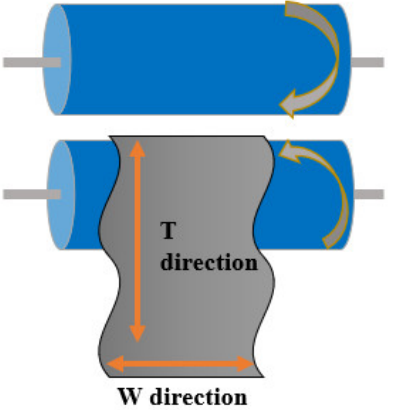
Figure 1. Schematic diagram of the direction determination.